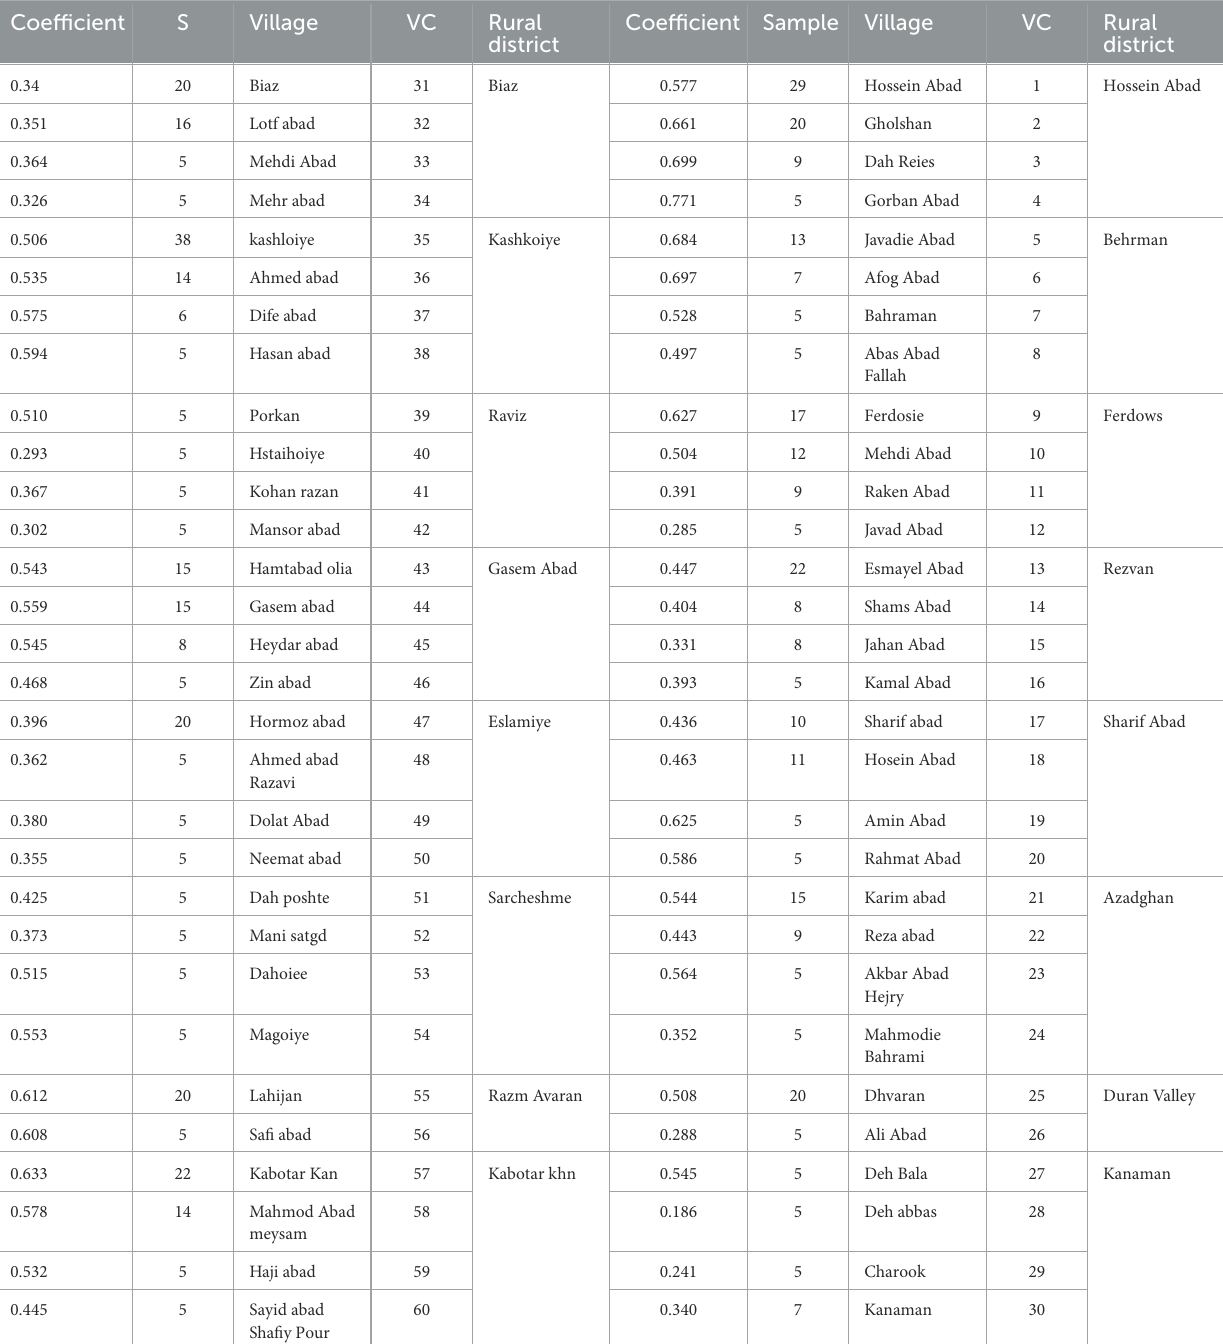
TABLE 7 The degree of resilience of pistachio farmers in rural areas of Anar and Rafsanjan cities against climate change.